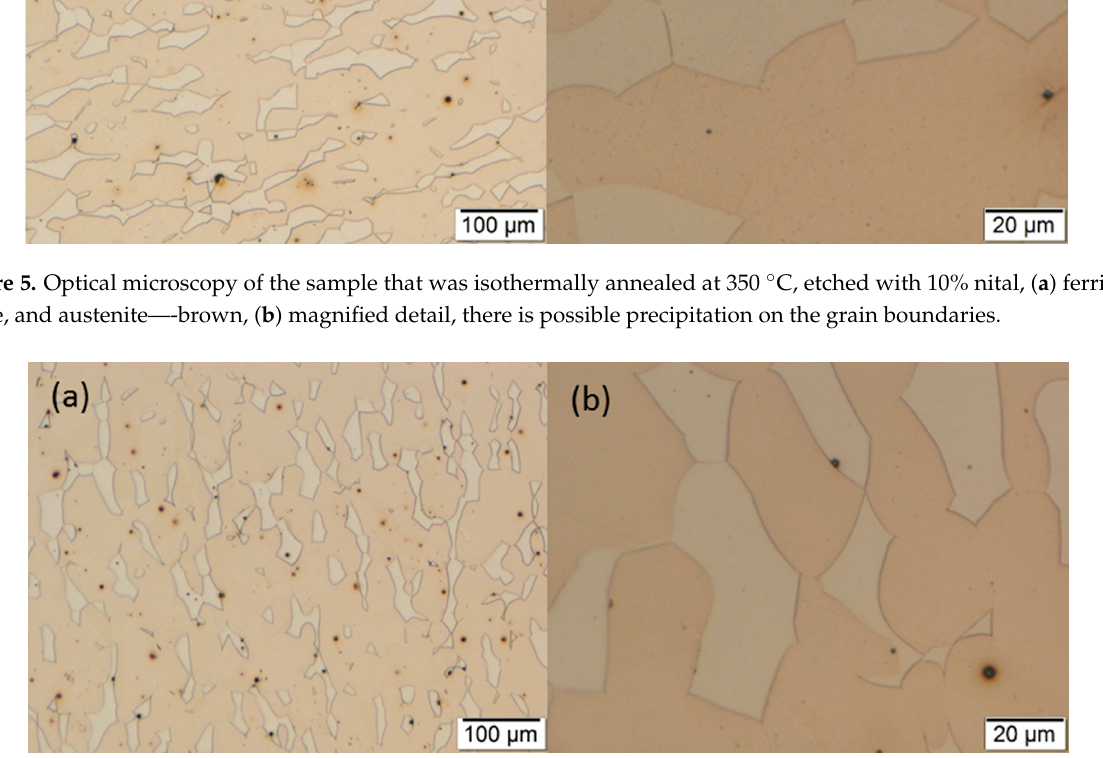
Figure 6. Optical microscopy of the sample that was isothermally annealed at 450 °C, etched with 10% nital, ( a ) ferrite–– white, and austenite––brown, ( b ) magnified detail, there is possible precipitation on the grain boundaries.